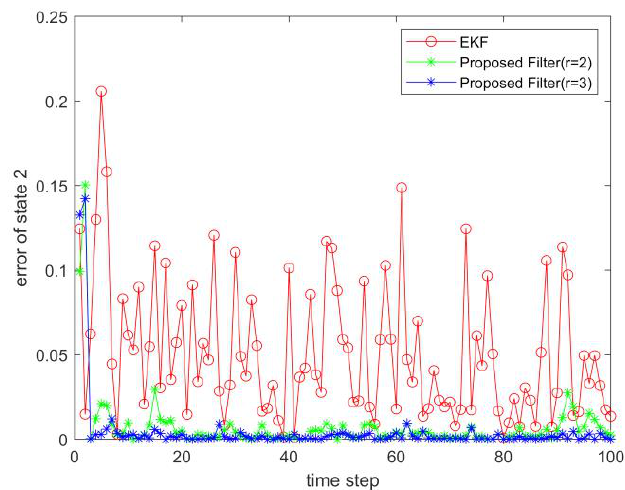
Figure 12. Estimation error of state 2.